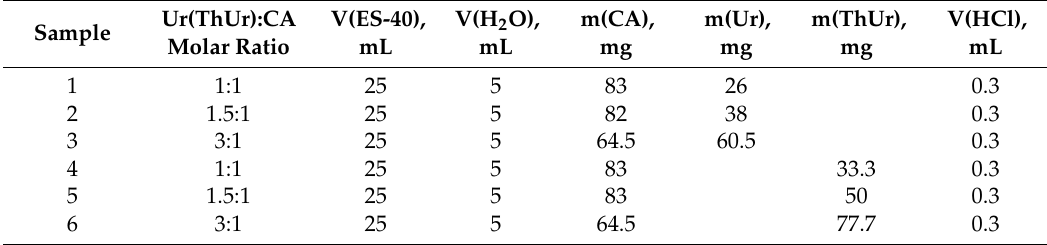
Table 3. Sample preparation: components ratio.